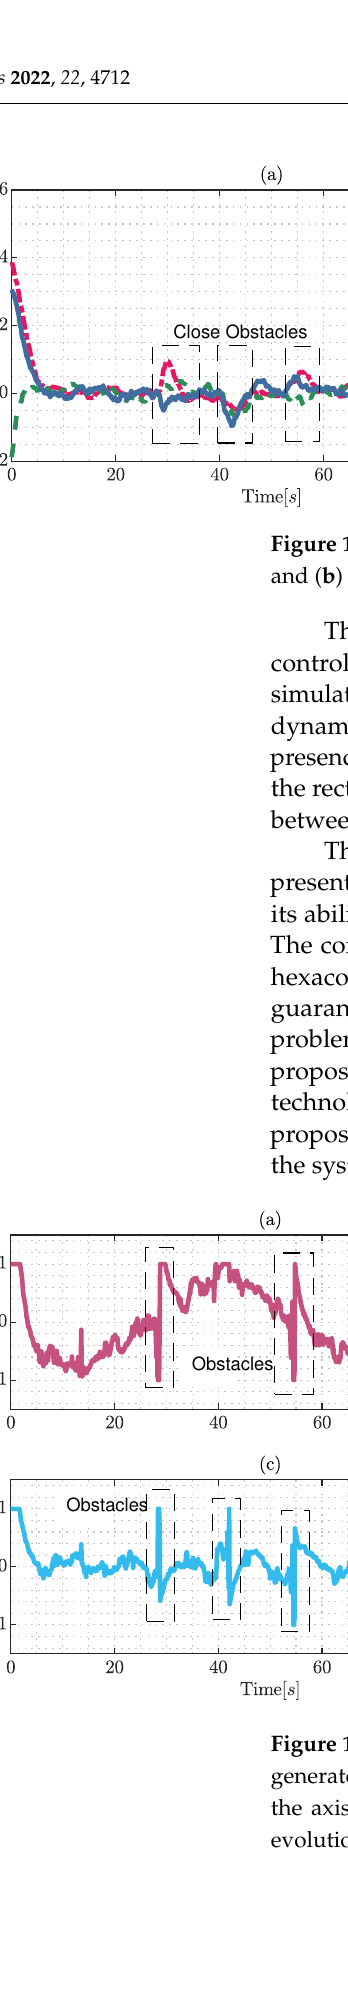
(cid:8) (cid:9) I y ; finally, ( c ) and ( d ) represent the